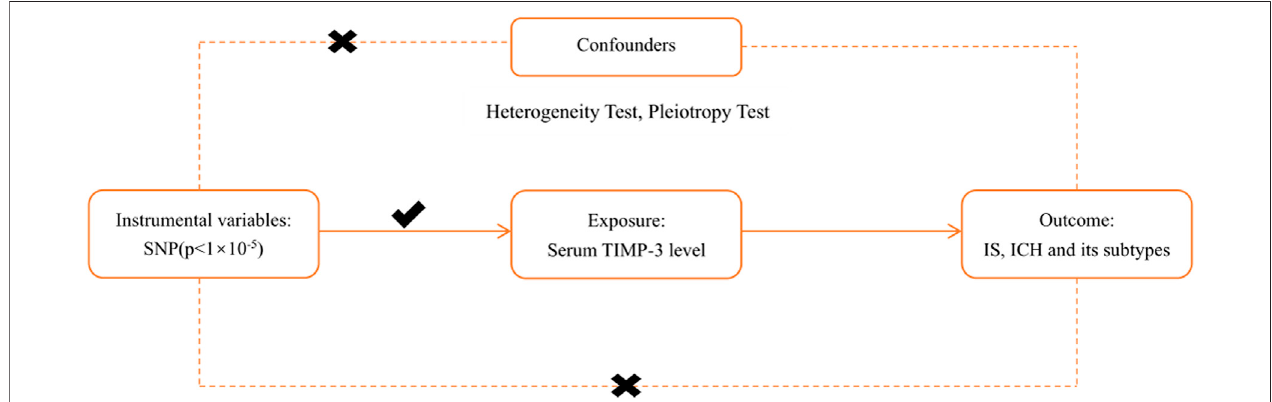
FIGURE1| Theprincipal diagramfor theMendelian randomizationstudy. IVW=inverse-variance-weighted,SNP =single nucleotide polymorphism,IS=ischemic stroke,LAS=largevesselischemicstroke,CES=cardioembolicischemicstroke,SVS=smallvesselischemicstroke,ICH=intracerebralhemorrhage.TIMP-3=Tissue inhibitors of matrix metalloproteinases